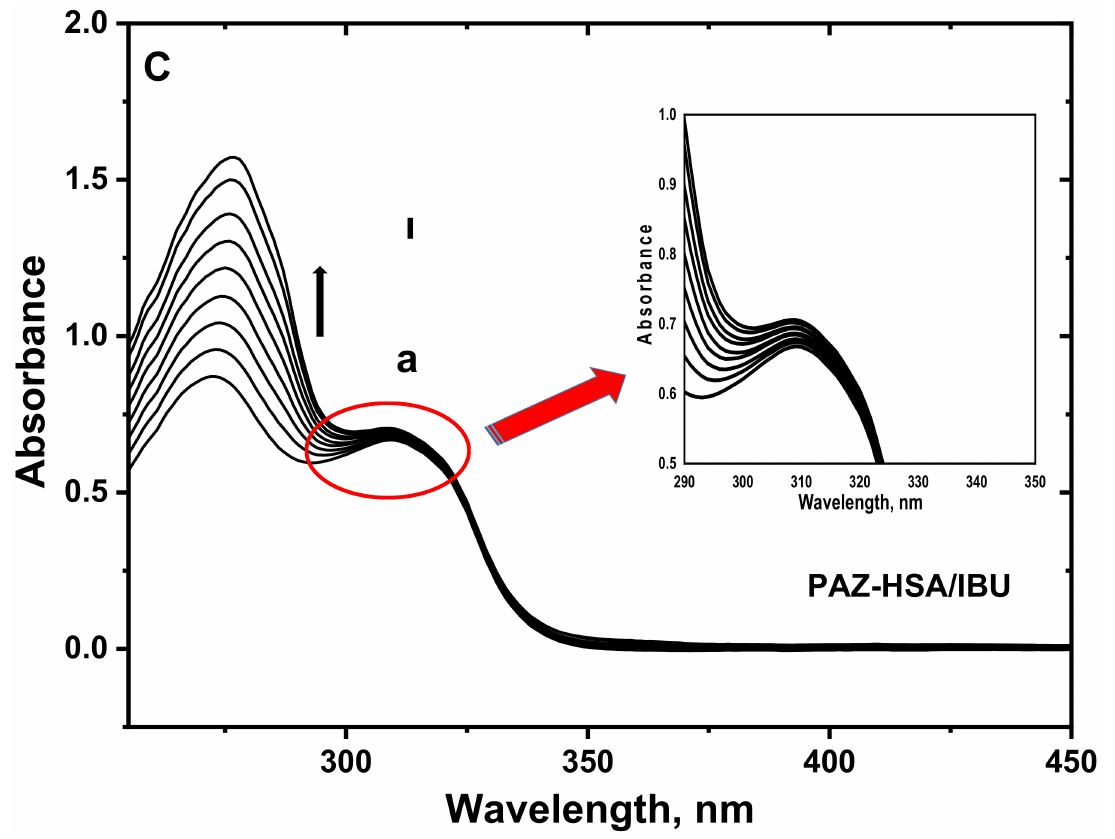
Figure 12. UV absorption spectra of 30.0 µ M PAZ in the presence of HSA with concentrations (a) to (ı): 0, 3.3, 6.6, 9.9, 13.2, 16.5, 19.8, 26.4 and 33.0 µ M ( A ), HSA-BIC ( B ) and HSA-IBU ( C ) at 298.15 K.